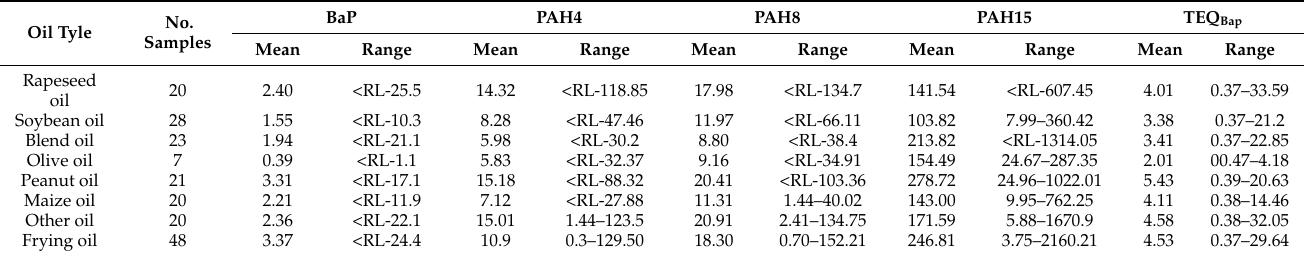
Table 5. PAH concentrations by BaP and sum of PAH4, PAH8, PAH15, and TEQ Bap as BaP concentra- tion estimated by TEFs in different types of vegetable and frying